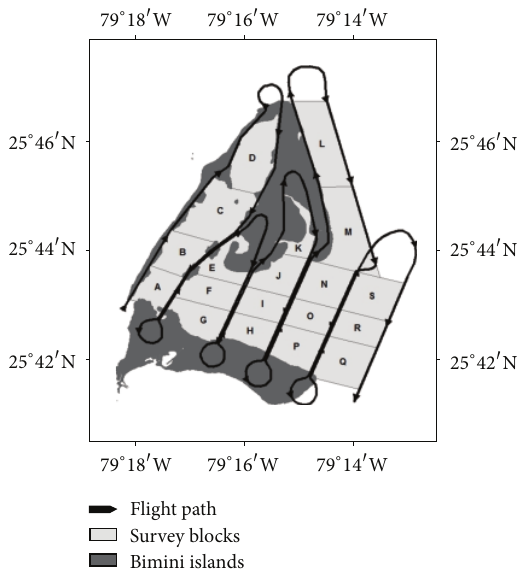
Figure 2: Aerial survey transect flight path depicted by the line. Arrows indicate the direction of the flight path. A–S represent stratified block sampling